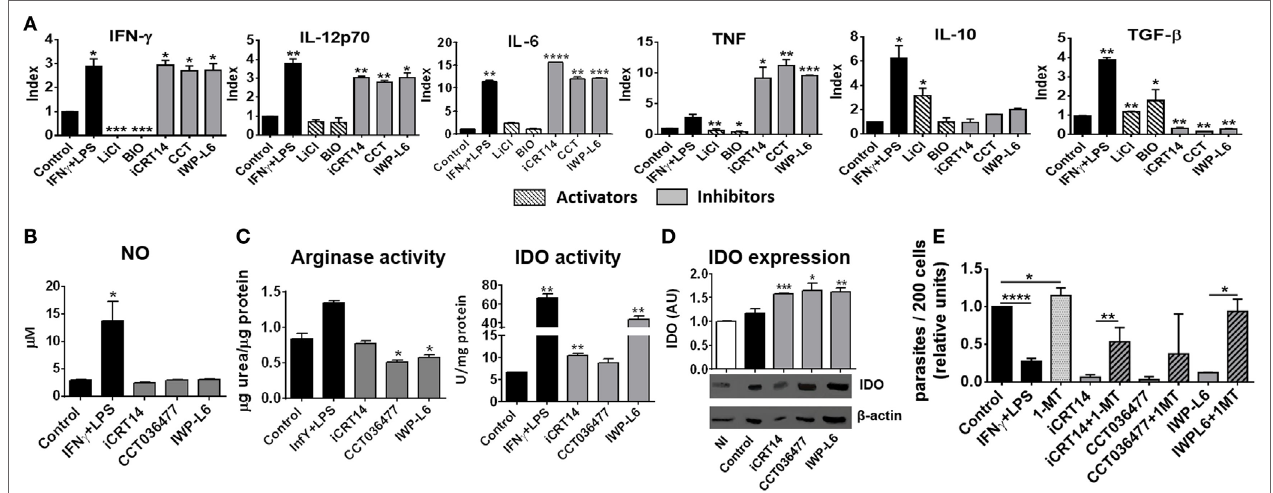
FigUre 6 | Pharmacological inhibition of Wnt pathway enhances anti- Trypanosoma cruzi activity of macrophages. Bone marrow-derived macrophages (BMM) were treated for 24 h with β -catenin activators (LiCl or BIO), specific β -catenin transcriptional inhibitors (iCRT14 and CCT036477), IWP-L6, 1-MT, IFN γ plus LPS or vehicle before being infected with T. cruzi trypomastigotes. (a) Cytokine levels assayed in 24 h post-infection (pi)-supernatants represented as Index obtained by dividing the cytokine release of inhibitors/activators-treated BMM for the cytokine release of the corresponding vehicle- treated BMM. The bars represent averages ± SEM from three independent experiments. (B) Nitrite concentration in 24 h pi-supernatant. (c) Arginase and indoleamine 2,3-dioxygenase (IDO) activity assayed in 24 h pi-cell (D) IDO expression. One representative experiment out of three performed for each condition is shown. The ratio of protein expression to β -actin is shown, and the results are expressed as the average of three independent experiments ± SEM. Abbreviation: AU, arbitrary units. Data points of nitric oxide (NO) concentrations, arginase, and IDO activity represent means ± SEM of data pooled from three cultures of the same experiment. All data are from one experiment representative of three in total. (e) Number of intracellular amastigotes determined by confocal microscopy at 72 h pi. The bars represent relative units, calculated as described in Figure 5B (* P < 0.05; ** P < 0.01; *** P < 0.001; and **** P <